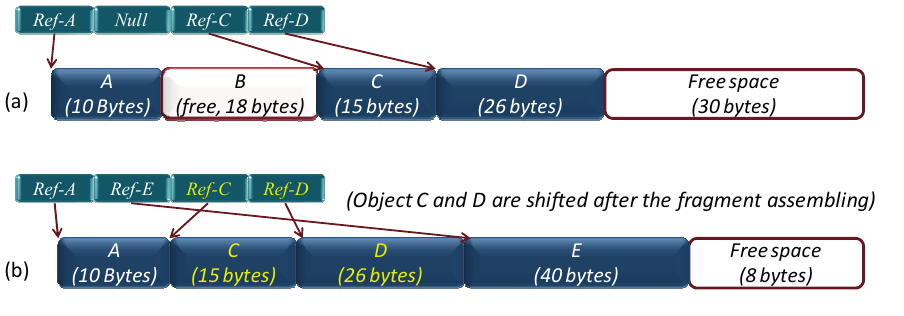
Figure 9. MIROS reactive defragmentation sequential fit allocation. If a 20-byte